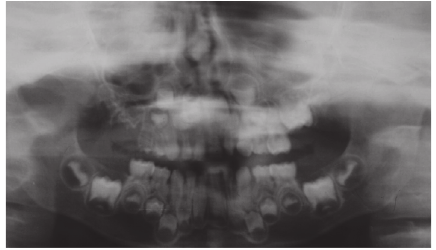
Figure 4: OPG radiograph.